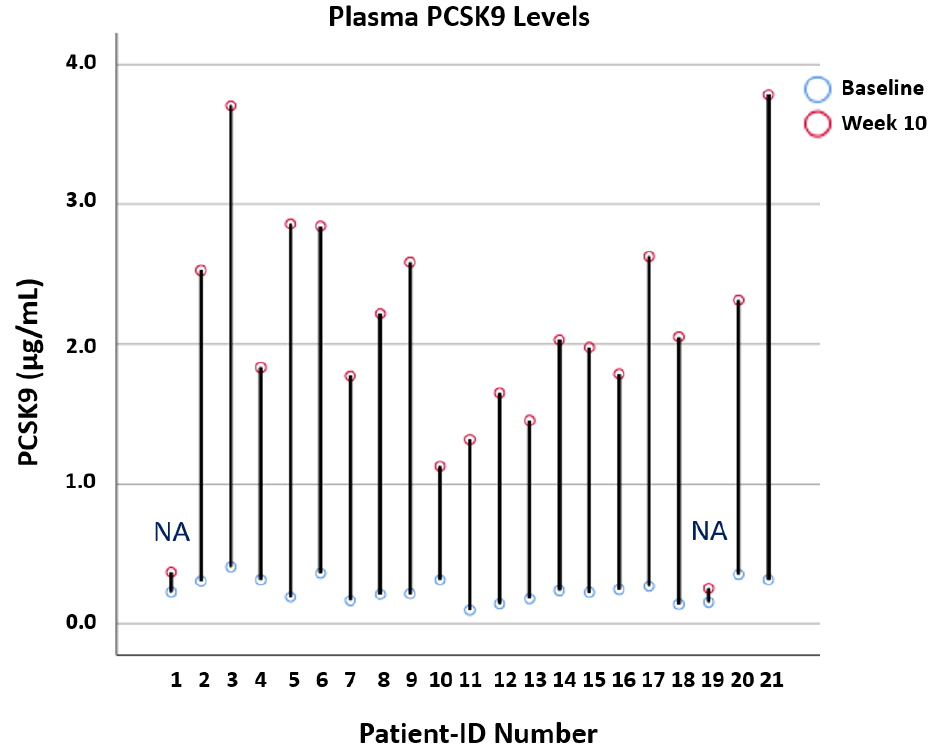
Figure 2. Plasma PCSK9 increase per patient in response to alirocumab treatment. Legend: The figure includes the 19 adherent patients and 2 non-adherent (NA) patients that did not receive alirocumab beyond week 2 ( n = 21). The used enzyme-linked immunosorbent assay measured total plasma PCSK9 levels, and thus did not differentiate between bound and unbound